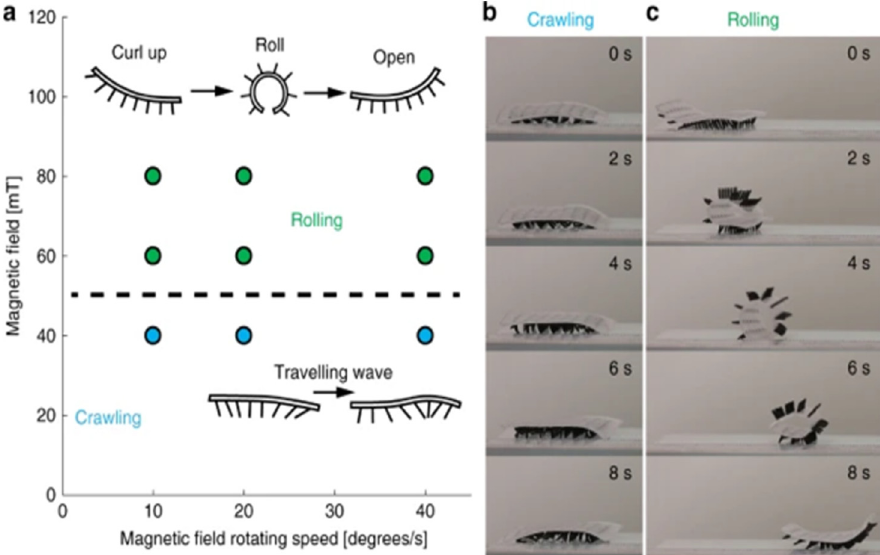
Figure 8. ( a ) Work from Gu H. et al. displays different modes of locomotion possible using magnetically actuated cillia including crawling and rolling. ( b ) Metachronal waves of the cilia structures leads to a crawling motion ( c ) When the magnetic field is larger than 60 mT the strong magnetic torque leads the soft robot to roll. Reprinted without changes with permission through the Creative Commons License 4.0 International License from Gu H. et al., Nature